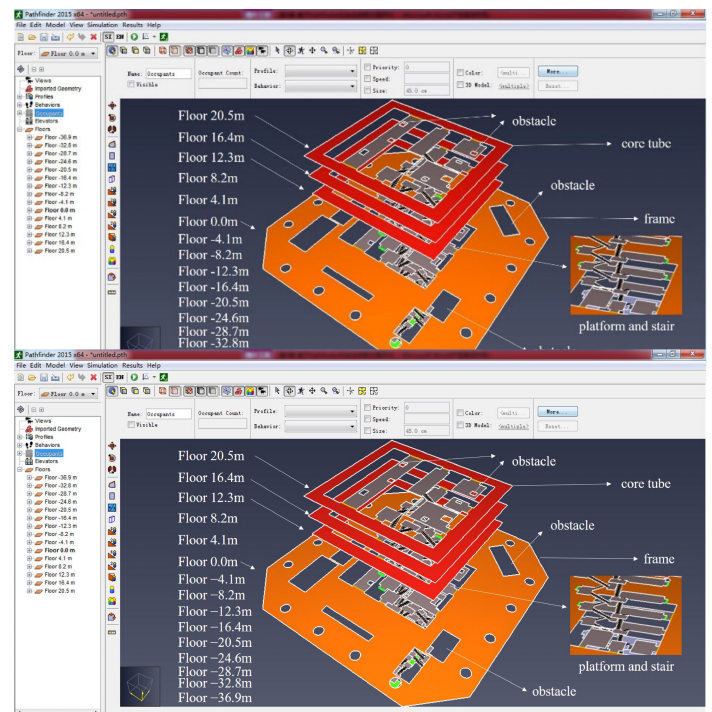
Figure 5. FTBCS model in